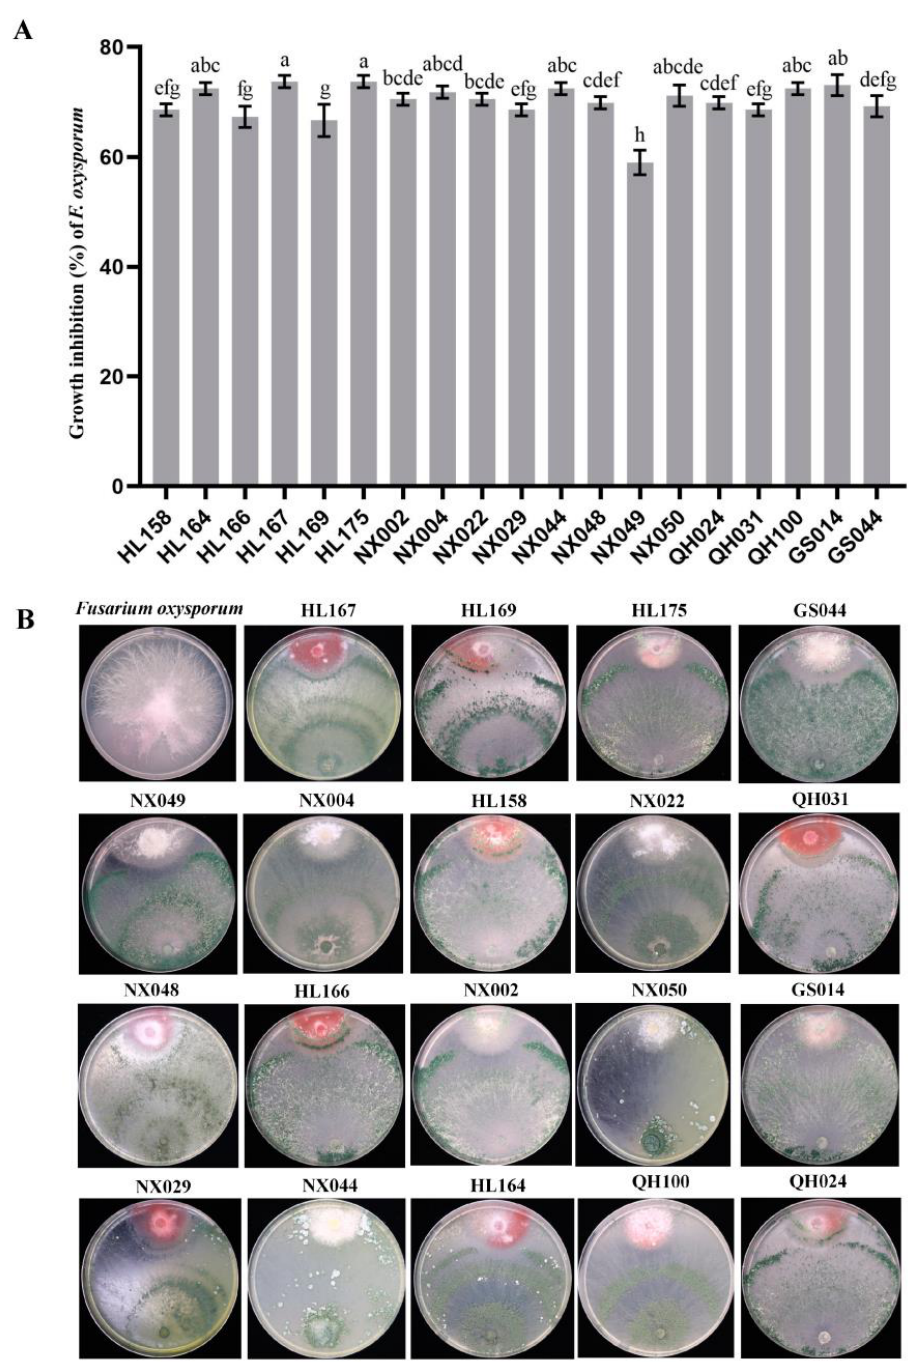
Figure 2. Inhibition effect of Trichoderma against F. oxysporum . ( A ) Inhibition rate of Trichoderma against F. oxysporum ; ( B ) Colony morphology in dual culture. Different lowercase letters indicate significant differences at p < 0.05. Bars represent the standard errors.